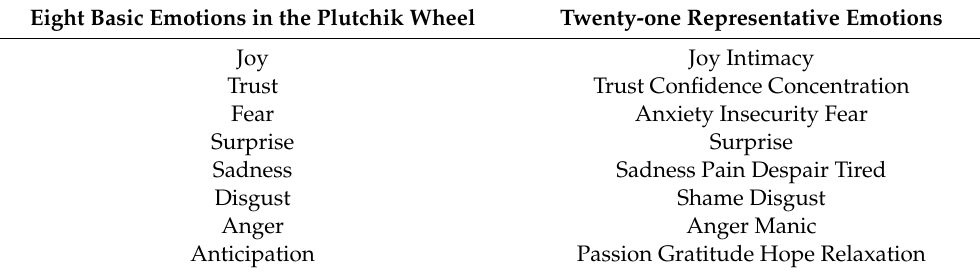
Table 2. Generalized emotion